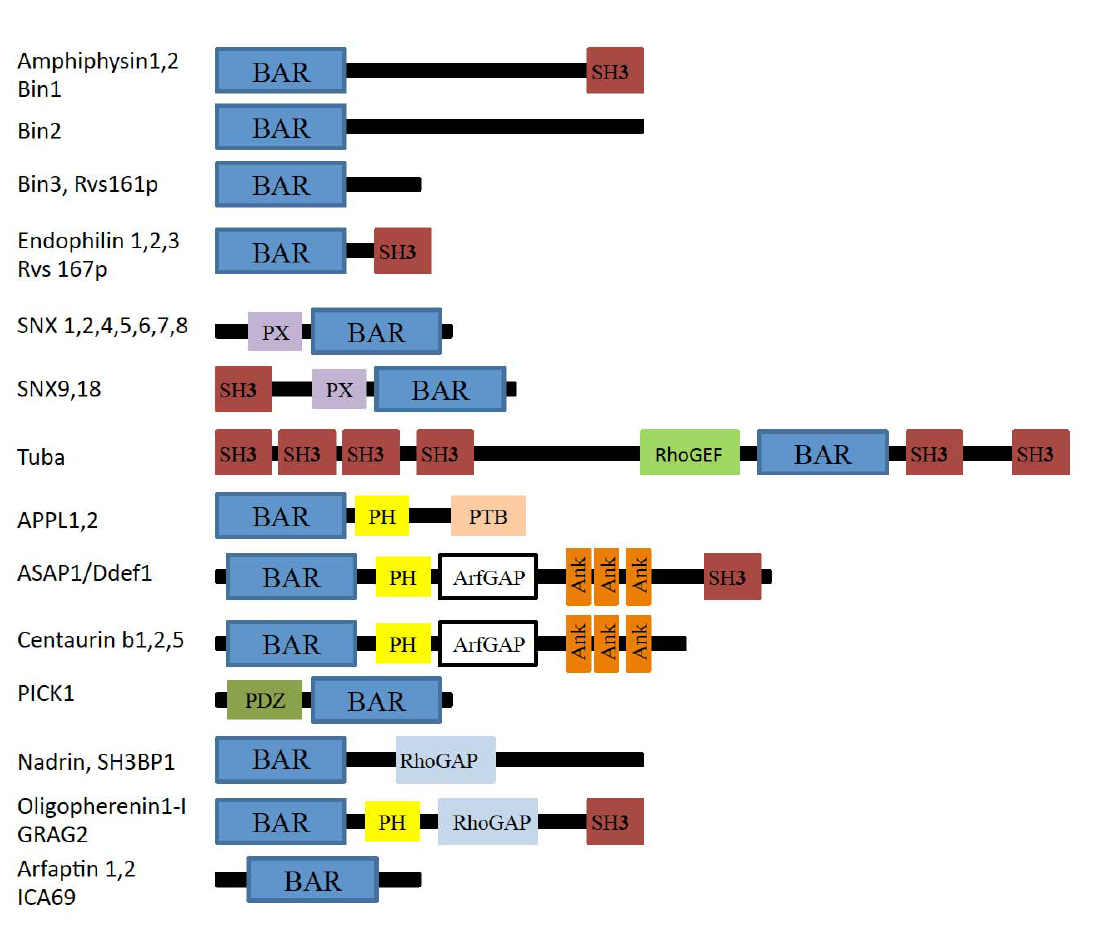
Figure 3. Domain organization of BAR subfamily proteins. BAR: